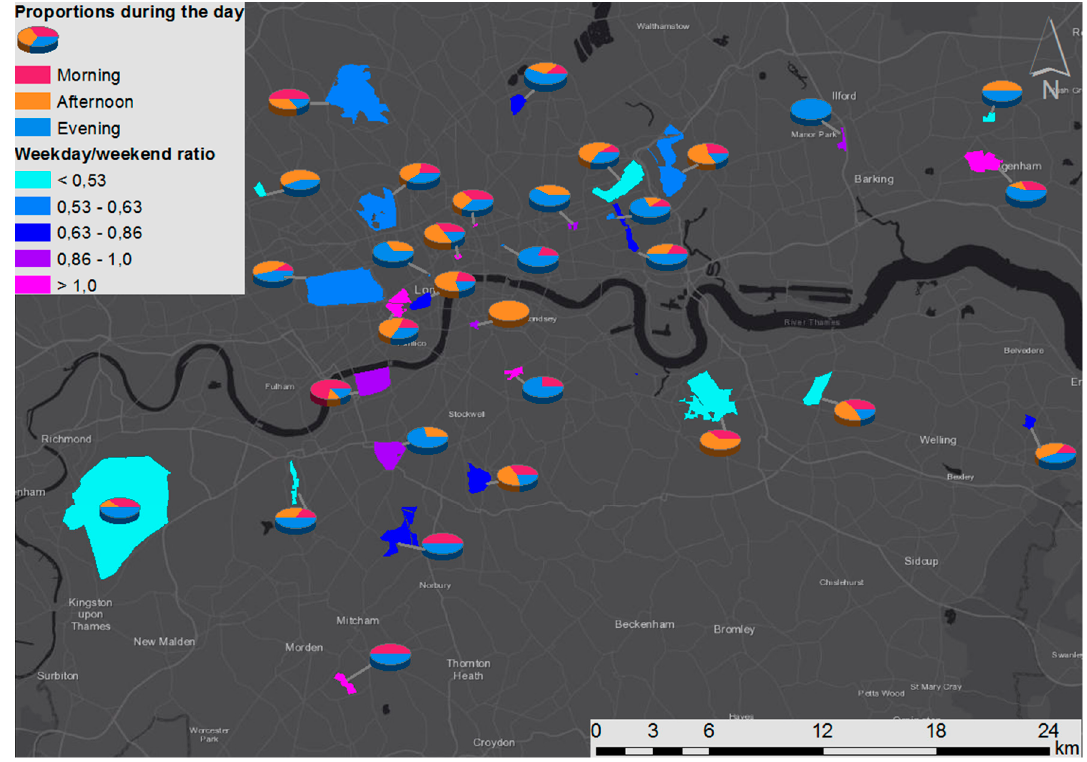
Figure 17. Proportion of fear tweets during the day, indicating weekday/weekend ratio as well.